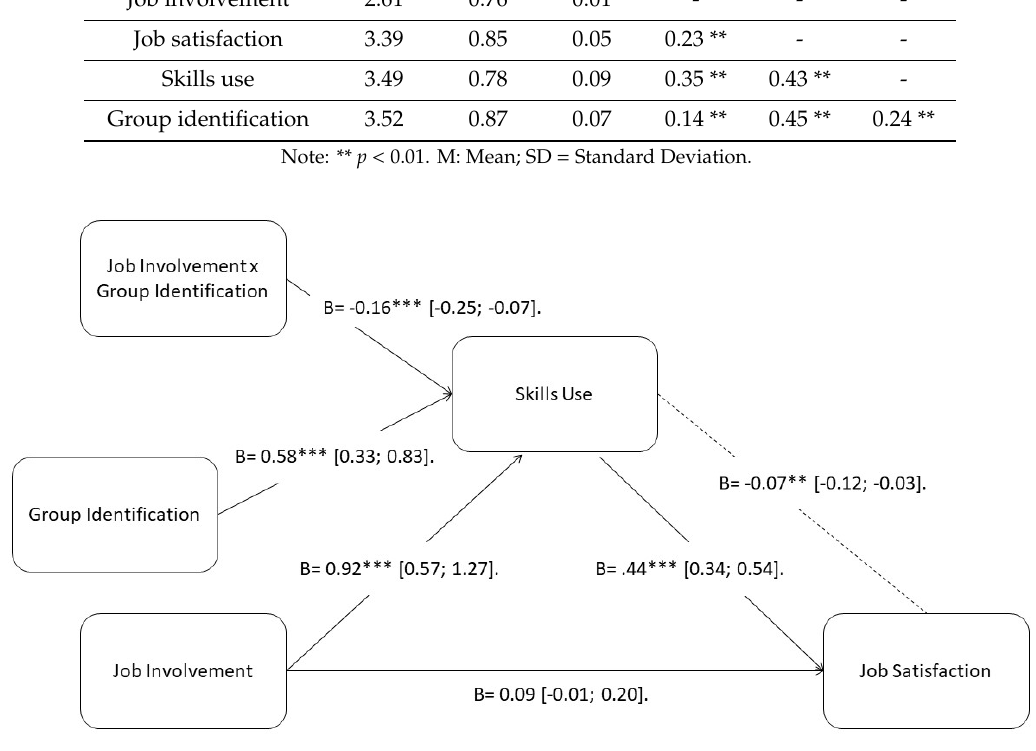
Figure 2. Statistical model where coefficients and effect sizes can be observed. Note: *** p < 0.001, ** p <